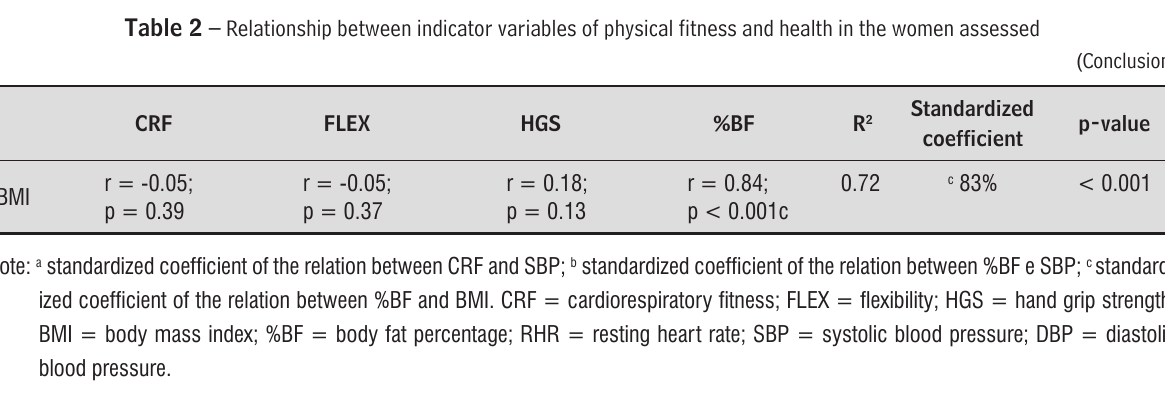
Table 2 – Relationship between indicator variables of physical fitness and health in the women assessed